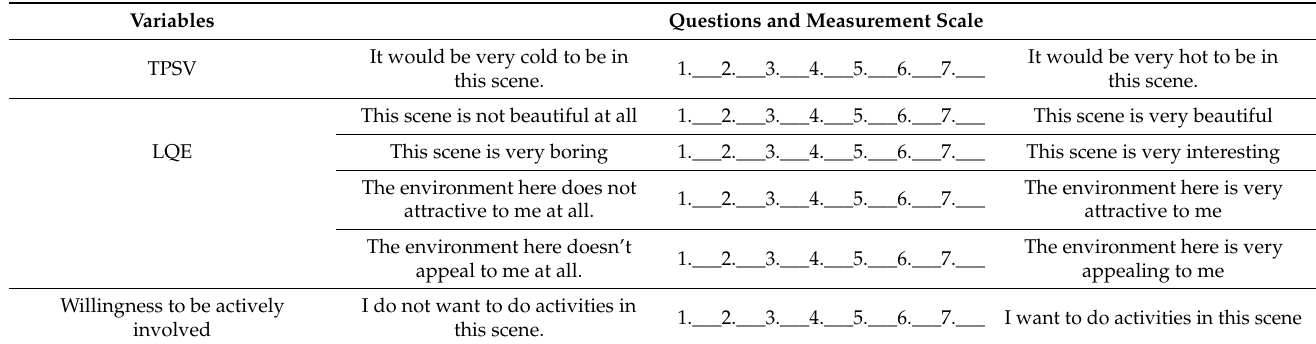
Table 2. Measurement scale of TPS, LQE, and activity